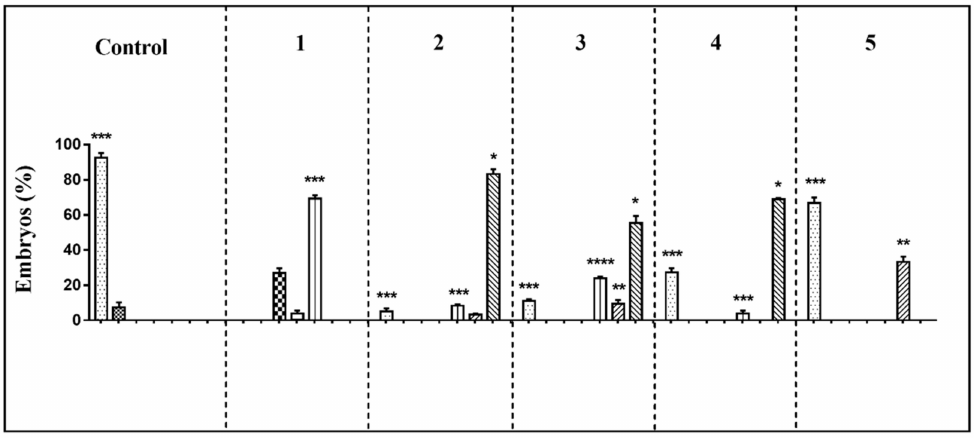
Figure 1. Sea urchin Paracentrotus lividus exposed before fertilization to di ff erent concentrations of mixtures of polyunsaturated aldehydes (PUA) + hydroxyacids (HEPE). Percentage of normal, malformed, early, delayed, and shortened plutei and gastrulae in controls (embryos grown in the absence of PUA / HEPE mixtures) and treated samples are reported. Five experiments are numbered on the top of the histogram. For the numerical data of the five experiments see also Supplementary Table S1. The statistical significance between di ff erent groups is reported as follows: * p < 0.05, ** p < 0.01, *** p < 0.001, **** p <